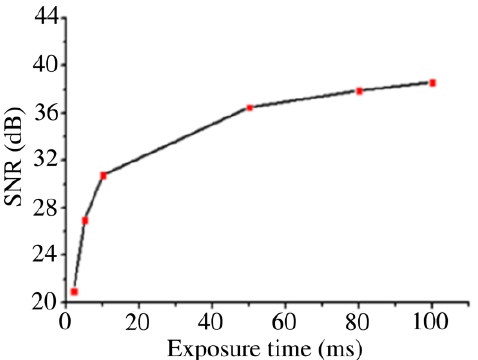
Figure 8. The SERS imaging result of BGERTs in different exposure times.